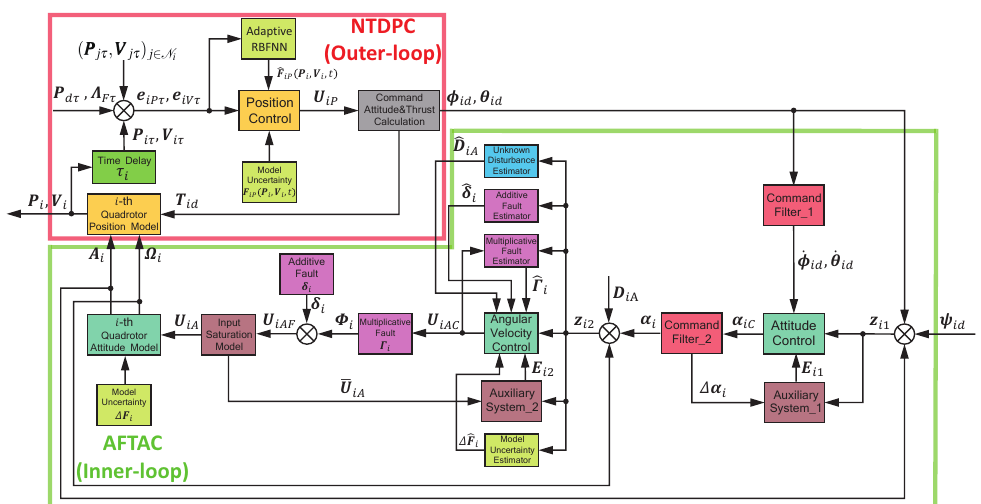
Figure 2. Block diagram of proposed formation control scheme